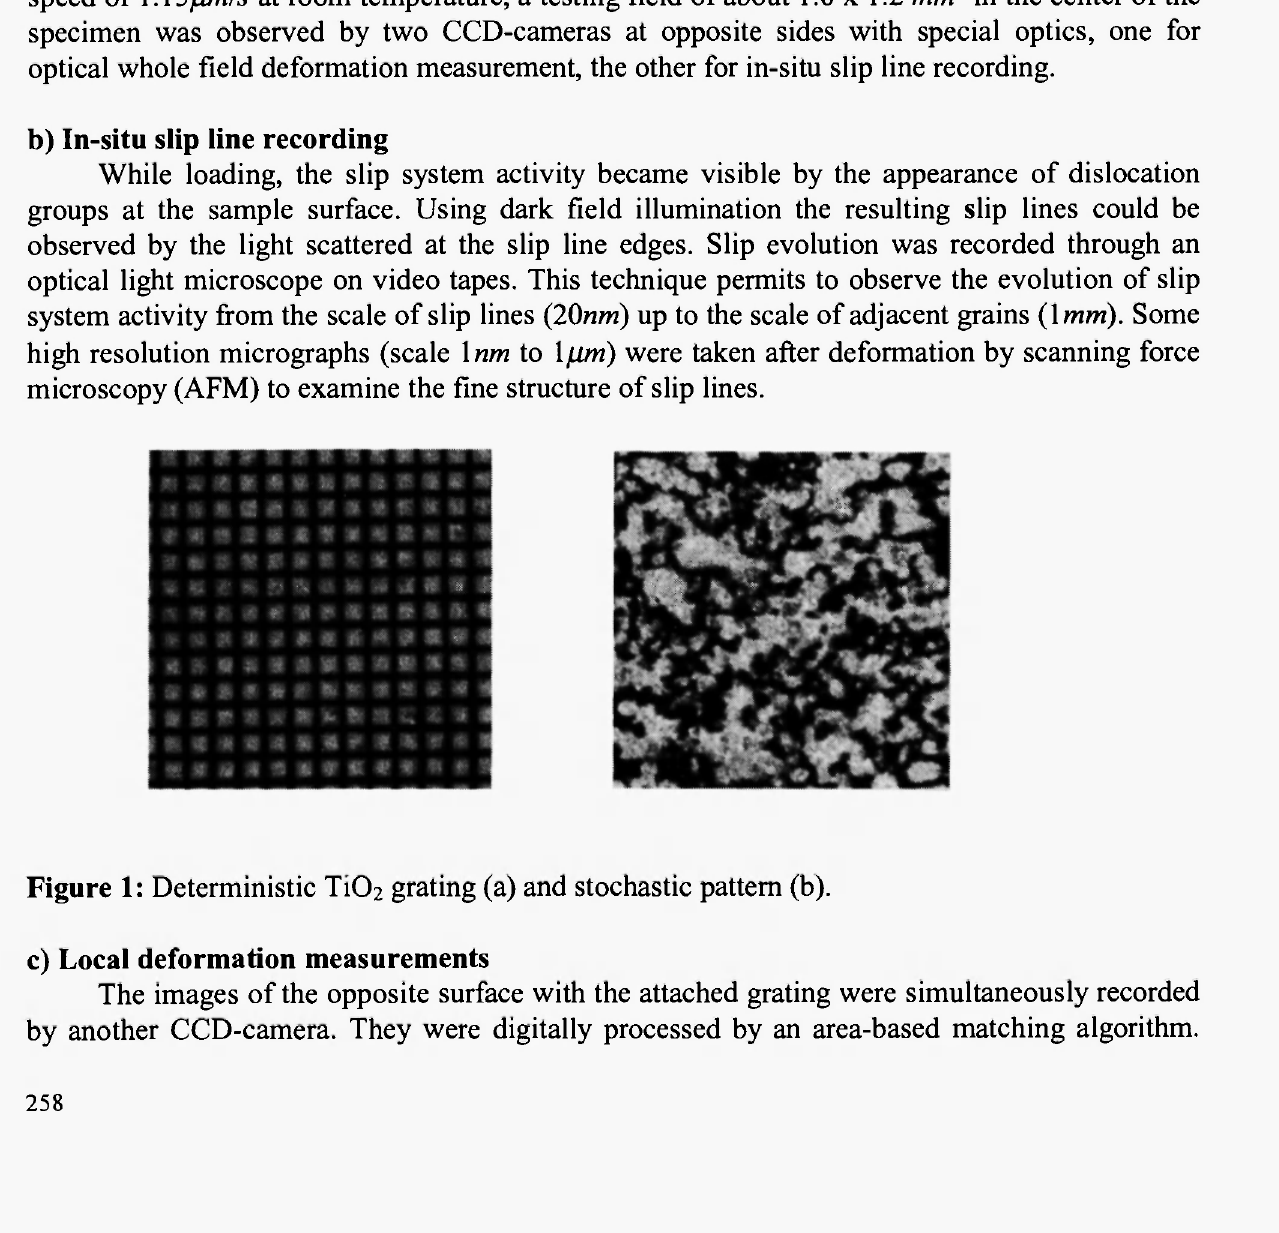
Figure 1: Deterministic T1O2 grating (a) and stochastic pattern